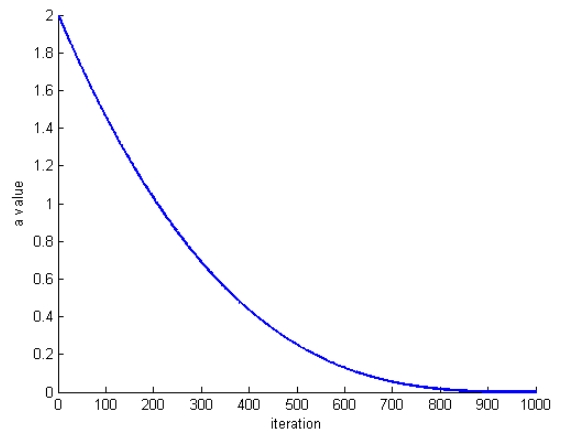
Figure 11. Changes of the factor a for G = 1000.